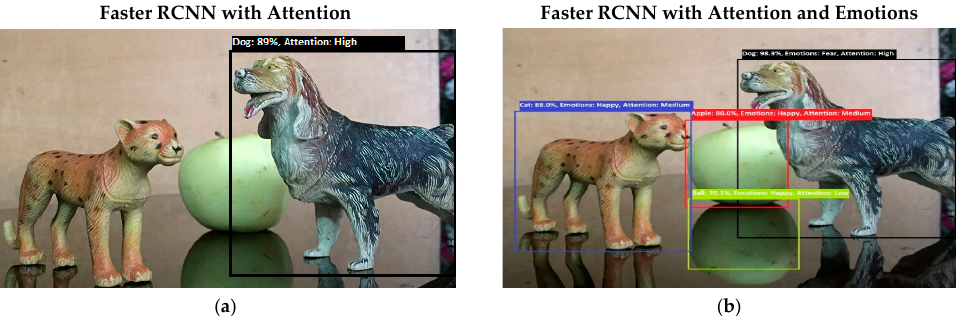
Figure 10. In ( a ), the same query as the previous one was generated to detect dog objects under the working of top-down attention. The system consolidates its attention toward the queried object. In ( b ) experiment, the same query as the previous one was generated to detect dog objects under the working of top-down attention. The system consolidates its attention toward the queried object based on strong fear emotion. In the following experimental results, some misrecognition occurs with the apple reflection. The system considers the apple reflection a ball object.